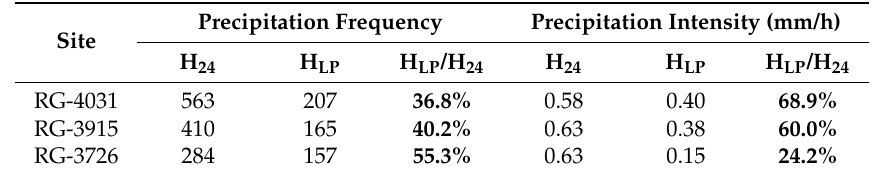
Table 4. Results of precipitation frequency and precipitation intensity in the rainy season of 2013. Precipitation Site